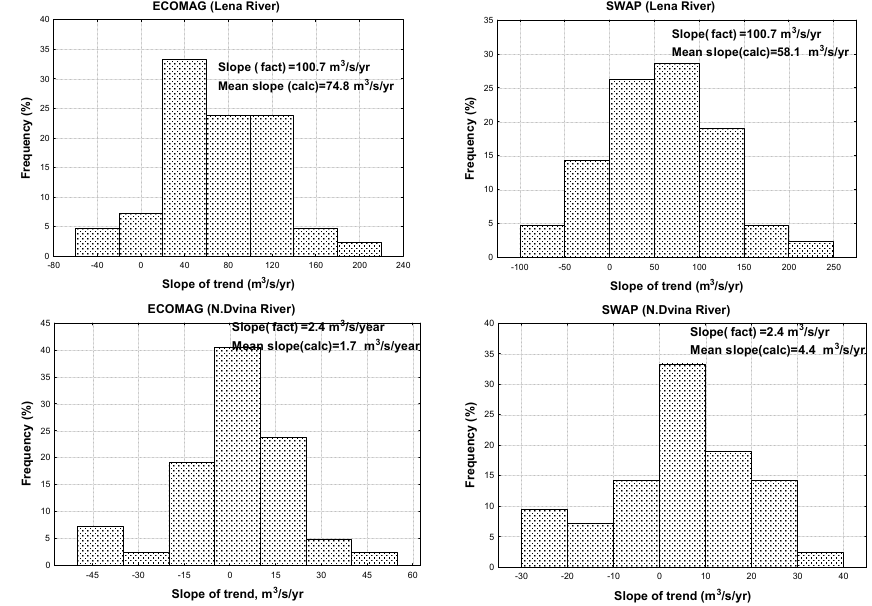
Figure 12. Histograms of the linear trend slope derived from the ensembles of simulated annual discharge time series.